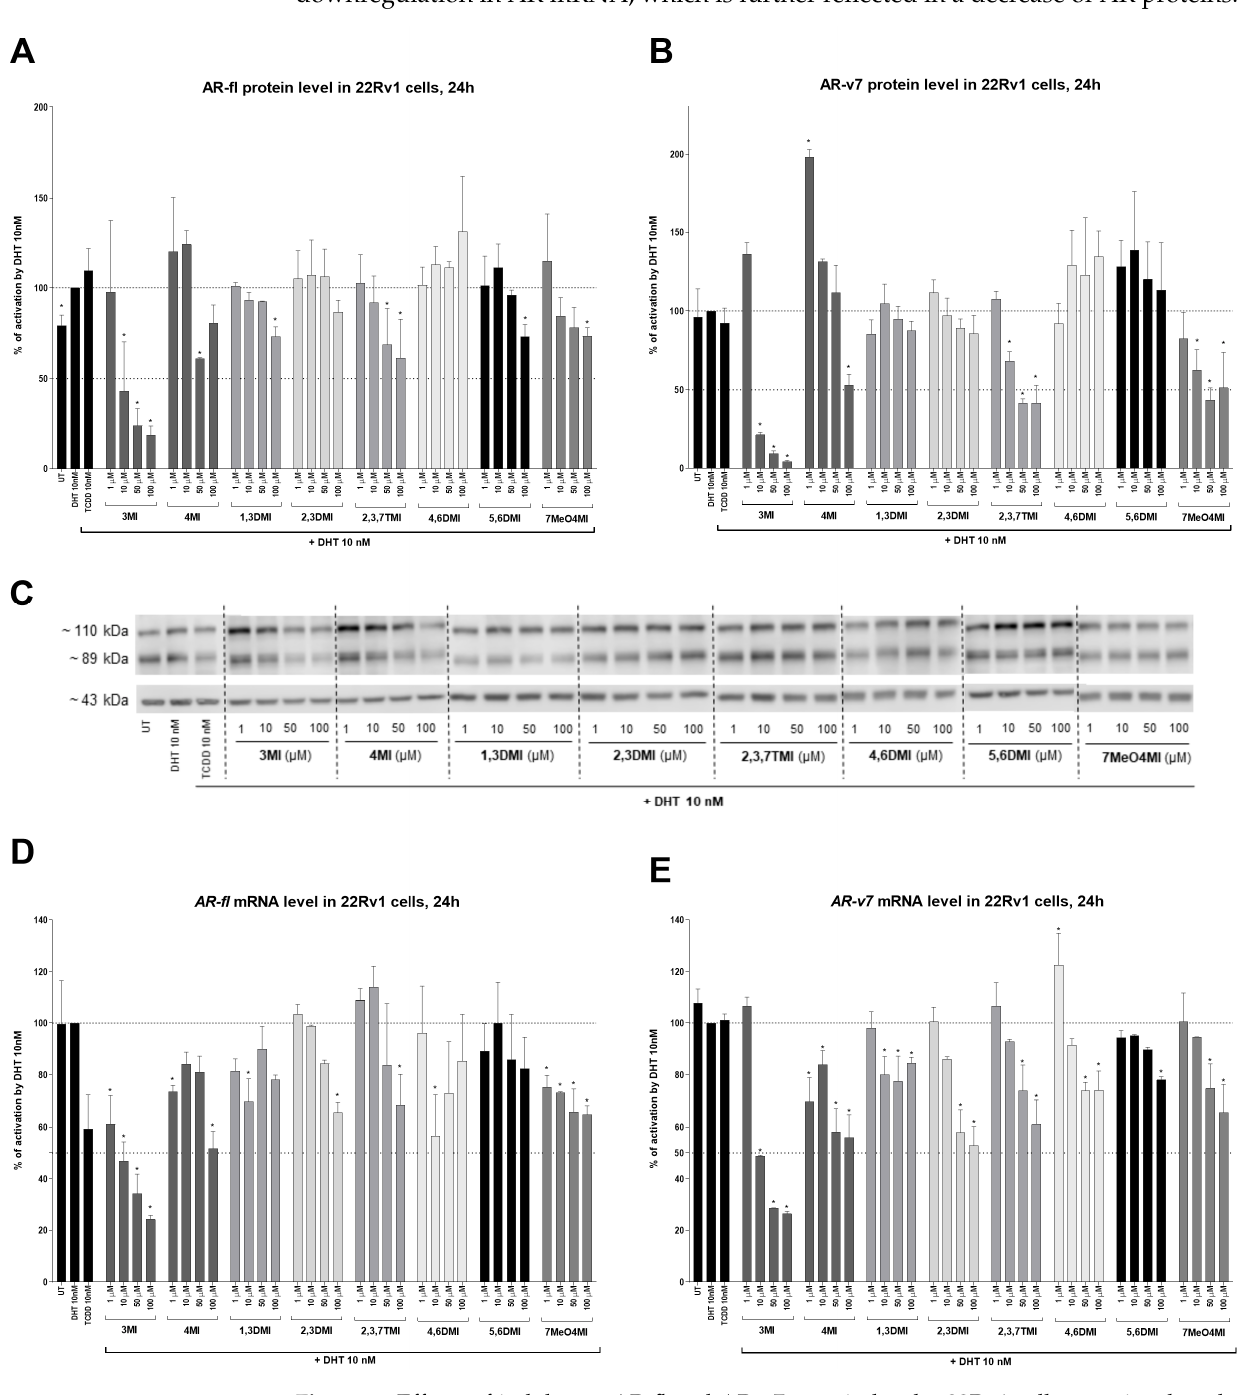
Figure 5. Effects of indoles on AR-fl and AR-v7 protein levels. 22Rv1 cells were incubated with indoles (1 µ M to 100 µ M) in the presence of 10 nM DHT or controls (UT; TCDD 10 nM; DHT 10 nM) for 24 h. The protein levels of AR-fl (110 kDa; A ) and AR-v7 (89 kDa; B ) were evaluated using semi-dry western blotting. The results obtained were normalized per β -actin (43 kDa). A representative blot is shown in ( C ). For comparison, AR-fl ( D ) and AR-v7 ( E ) mRNA levels were also determined using RT-qPCR. The data obtained were normalized per the housekeeping gene GAPDH . The results are expressed in percentages, when DHT 10 nM is set to 100%. * represents a significant difference (p < 0.05) between DHT and compound+DHT-treated cells ( C , D , E ).